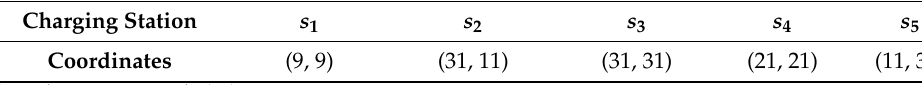
Table 2. Coordinates of deployed charging